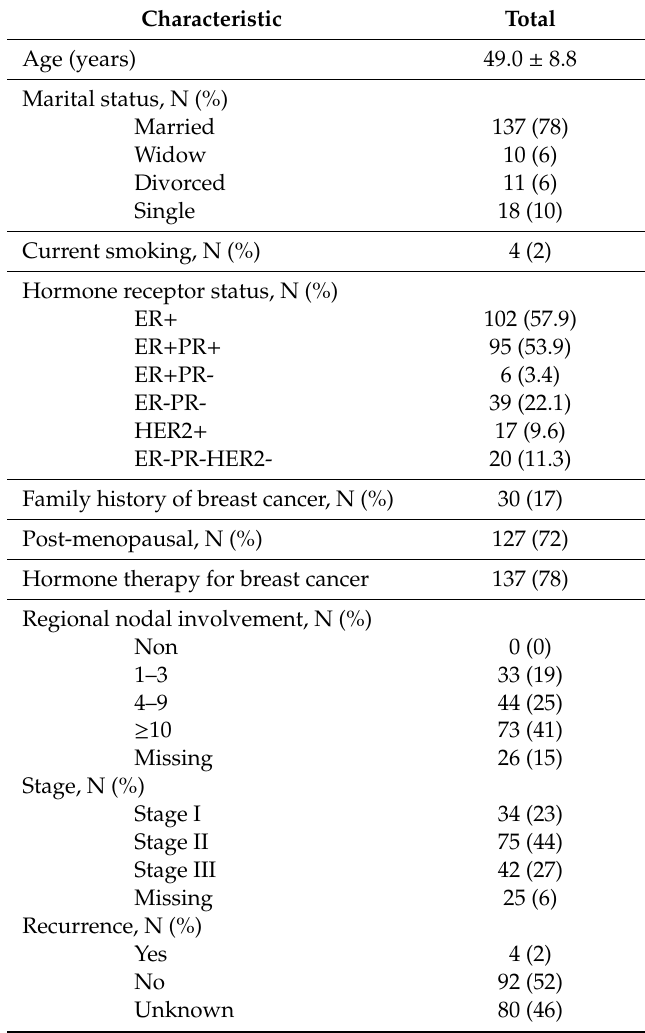
Table 1. Basic characteristics of the study